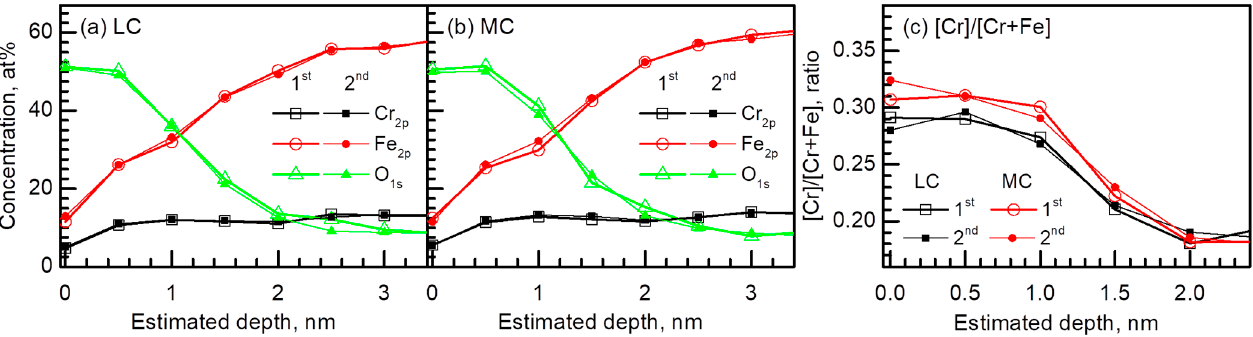
Figure 12. Chemical composition depth profiles of the passive films of the ( a ) LC and ( b ) MC samples analyzed through XPS. ( c ) Cation fraction of Cr (Cr/(Cr+Fe), in at%) in the passive films of the specimens.